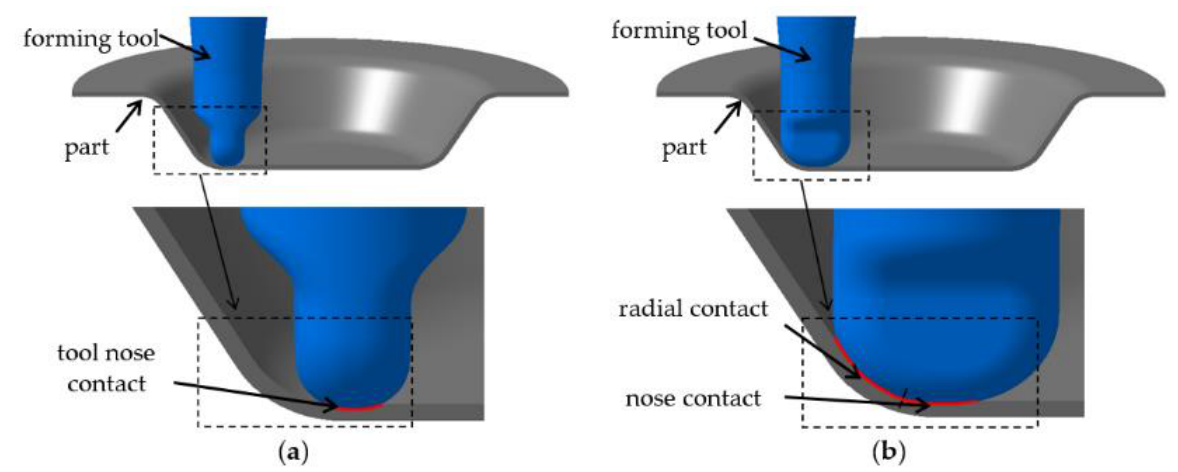
Figure 3. Interactions between the forming tool and part wall in all five stages during a complete tool rotation: ( a ) contact only on the tool nose at 0°, 180° and 360°, respectively; ( b ) radial and nose contact at 90° and 270°.